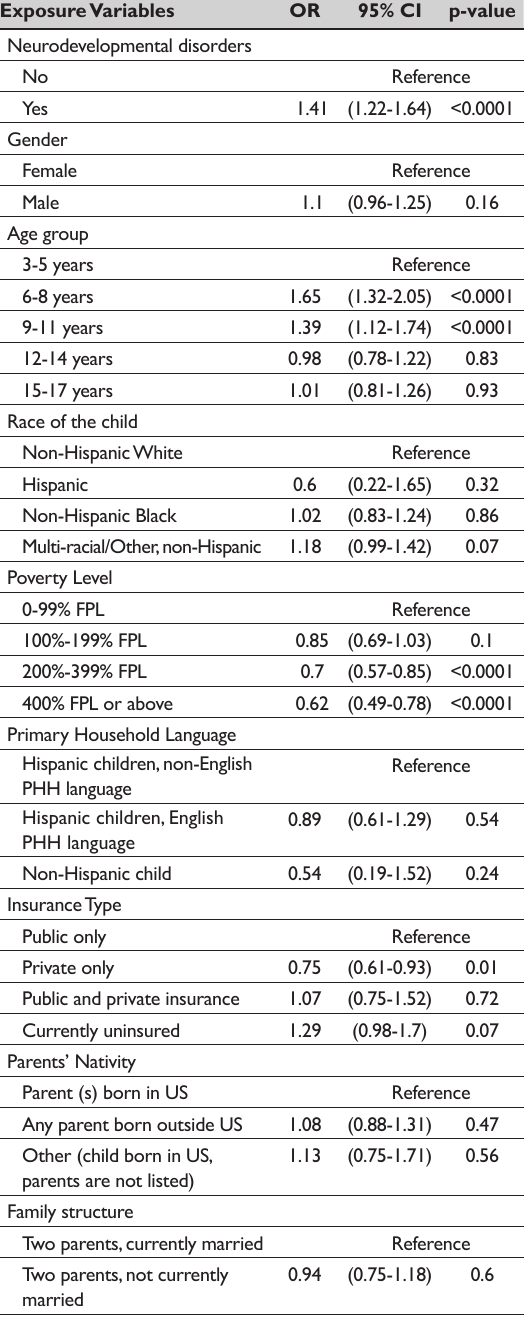
Table 1. Adjusted association